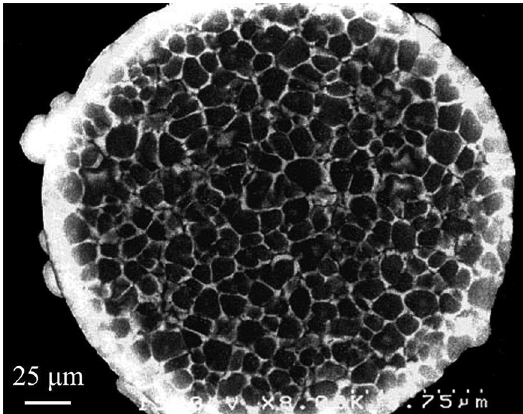
Figure 9. Scanning electron micrograph of atomized Al alloy powder 33 .